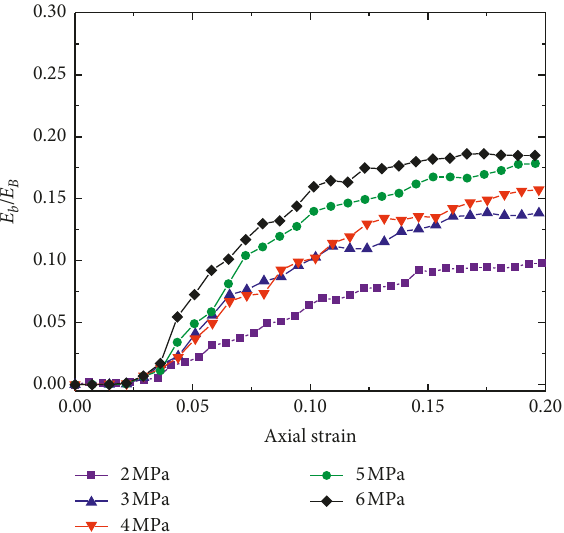
Figure 19: Ratio of breakage energy and boundary